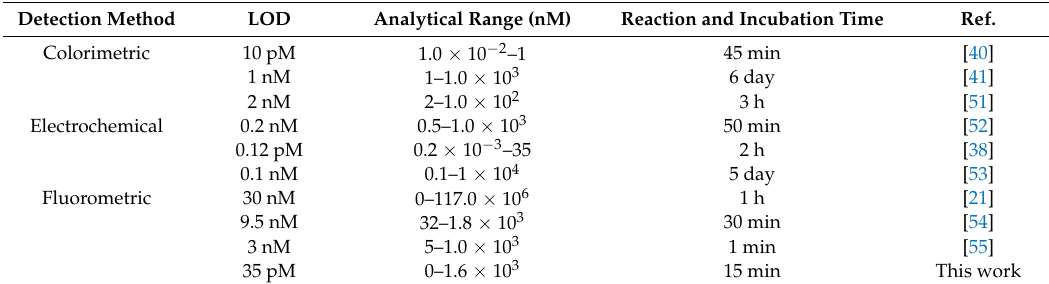
Table 6. Comparison of different detection